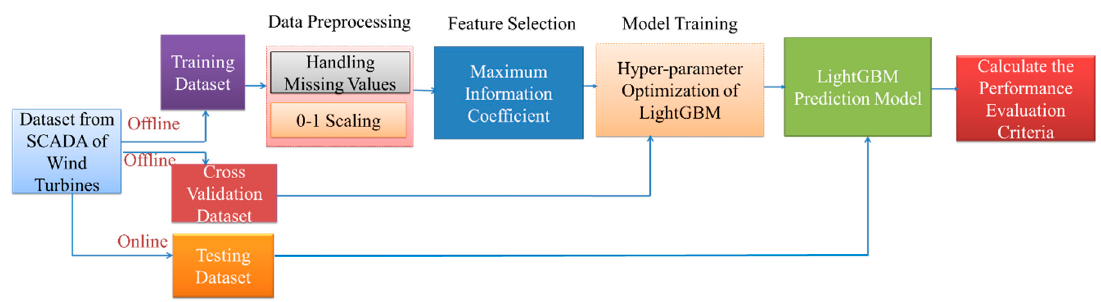
Figure 1. Flowchart of an improved LightGBM algorithm for wind turbine fault diagnosis.